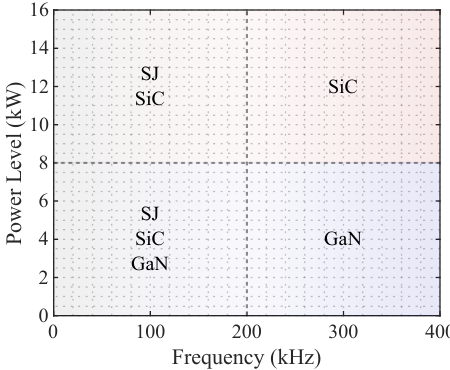
Figure 11. Application trends for SiC, SJ and GaN